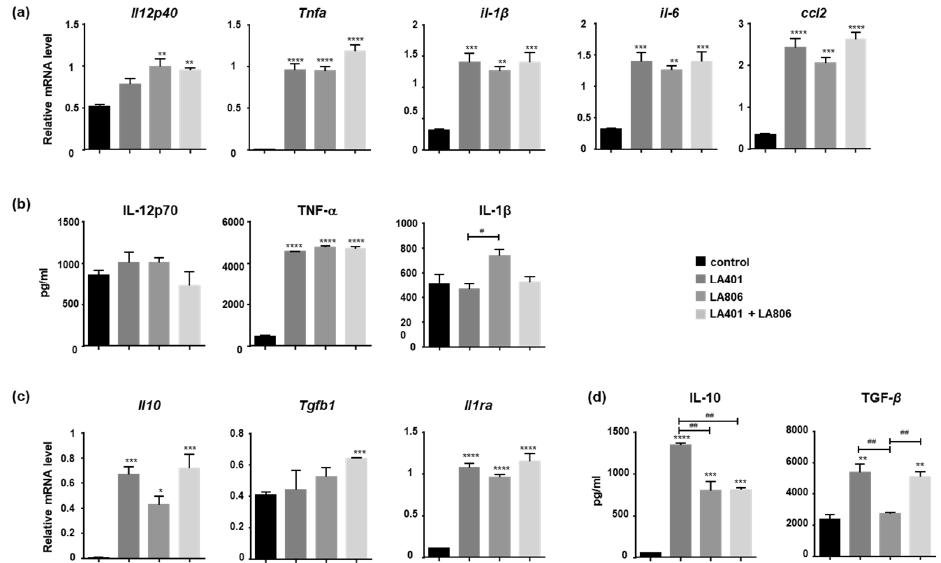
Figure 6. In vitro modulation of pro- and anti-inflammatory cytokine release of macrophages by Lactobacillus helveticus LA401 and/or Lactobacillus gasseri LA806. ( a ) mRNA and ( b ) protein levels of pro-inflammatory cytokines ( Il12p40 , Tnfa , Il1b , Il6 and Ccl2; IL-12p70, TNF- α , IL-1 β ); ( c ) mRNA and ( d ) protein levels of anti-inflammatory cytokines mRNA ( Il10 , Tgfb1 and Il1ra ; IL-10, TGF- β ) of IFN- γ and LPS-activated macrophages treated with LA401 and LA806 strains alone or in combination. Results are presented as means ± SEM of triplicates. * p ≤ 0.05, ** p ≤ 0.01, *** p ≤ 0.005, **** p ≤ 0.001 compared to control. # p ≤ 0.05, ## p ≤ 0.01 compared to treatments.